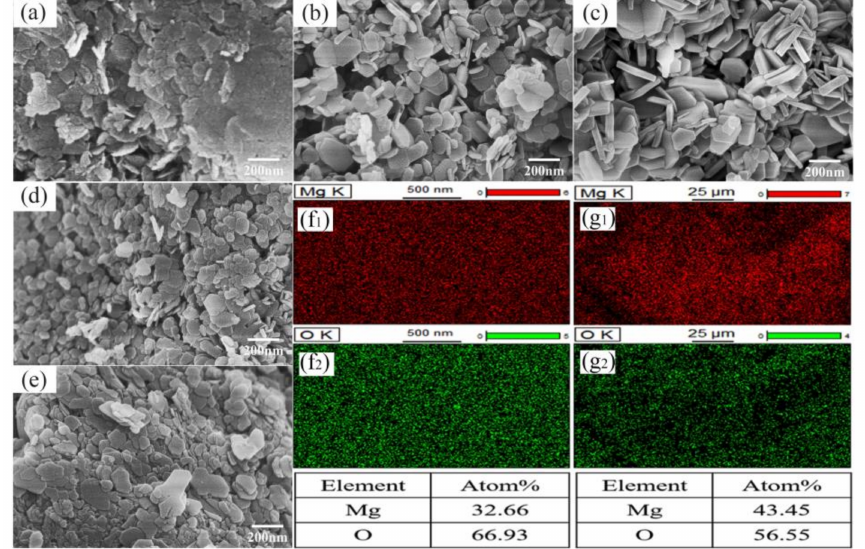
Figure 7. SEM images of products: ( a ) Pure Mg, ( b ) Mg-6%NiCl 2 , ( c ) Mg-6%CoCl 2 , ( d ) Mg-6%CuCl 2 , ( e ) Mg-6%FeCl 3 . ( f , g ) are the EDS images of ( c ) product of Mg-6%CoCl 2 ,